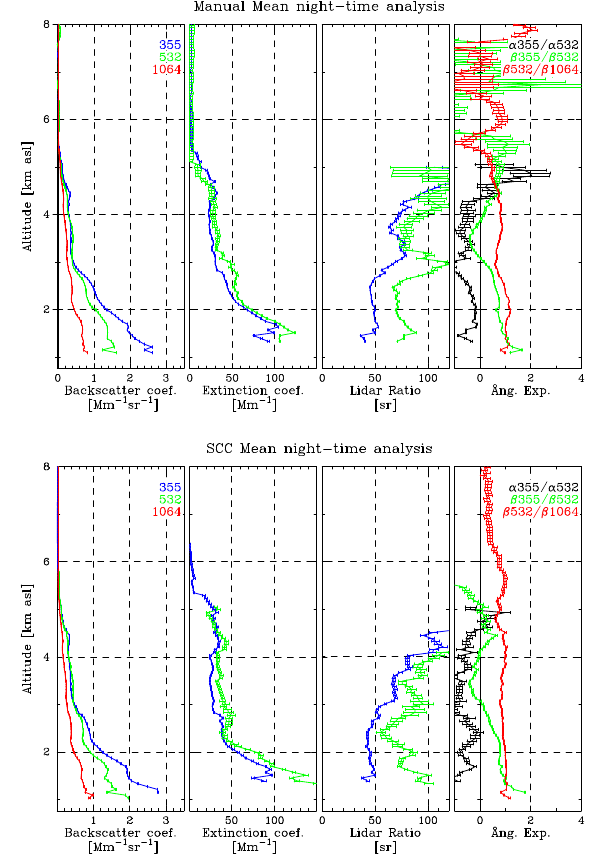
Figure 9. Mean night-time analysis comparison for the Potenza sta- tion (MUSA system). In the upper graph the mean profiles obtained using the manual analysis are shown, while in the bottom graph the results obtained by the SCC are presented. Several measure- ment cases (see Table 2) have been analysed, and the correspond- ing backscatter and extinction profiles have been averaged (left two panels of each graph). The other two panels of each graph show the lidar ratios and the Ångström exponents, respectively as calculated from the mean aerosol extinction and backscatter